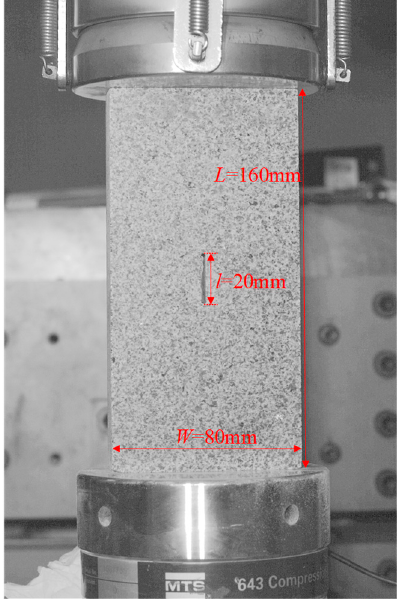
Figure 2. Granite slab specimen with fissure.